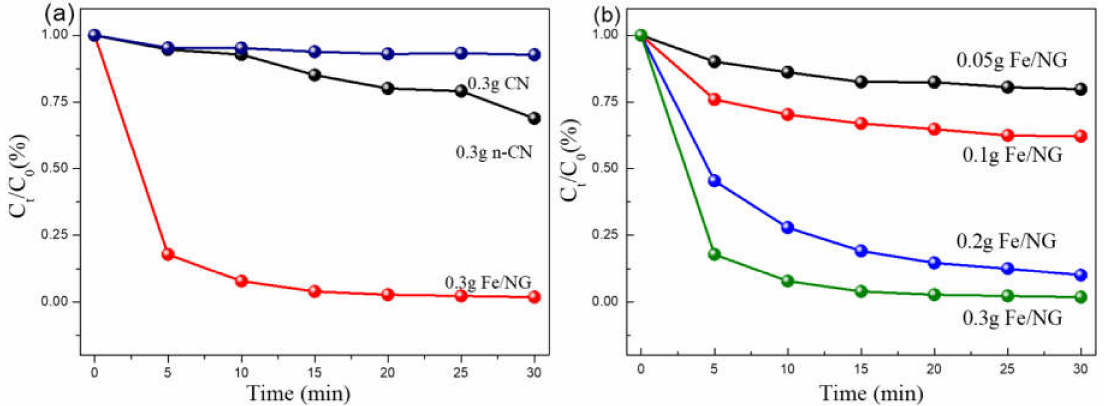
Figure 6. ( a ) Degradation of MB by CN, n-CN, and Fe/NG: C 0MB = 40 mg L − 1 , m/V = 1 g L − 1 . ( b ) Degradation of MB by different dosage of Fe/NG: C 0MB = 40 mg L − 1